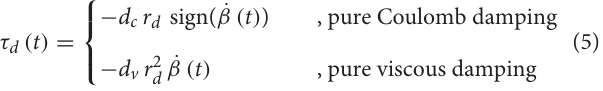
Simulations were performed using MATLAB